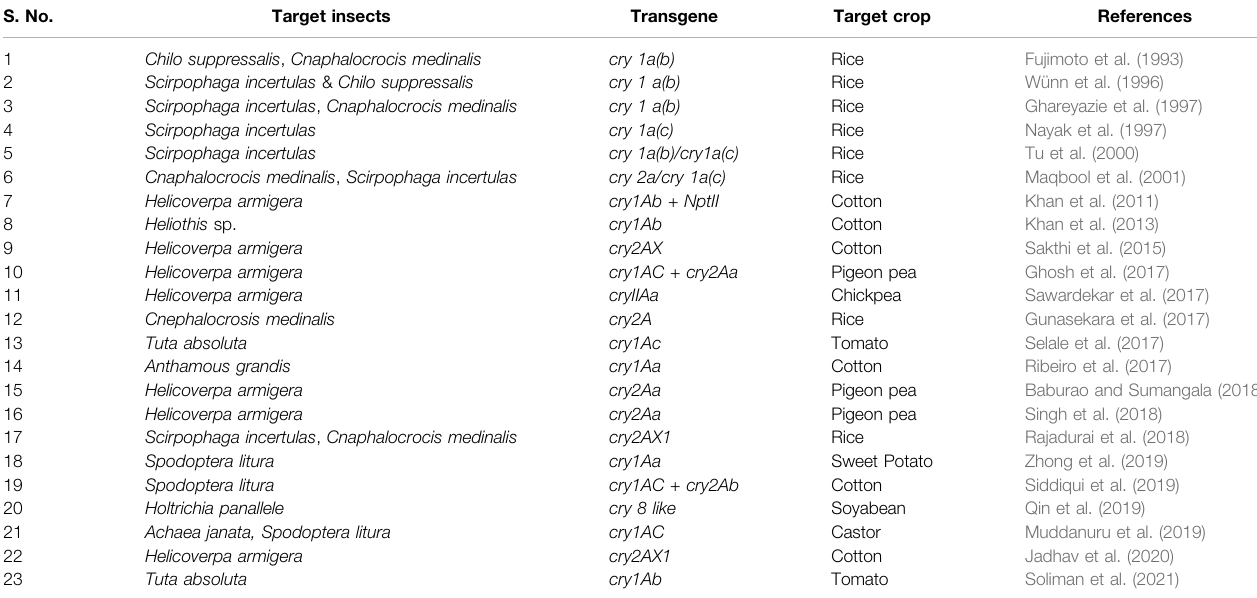
TABLE 1 | Transgenic crops carrying Bt genes for insect resistance. S. No.